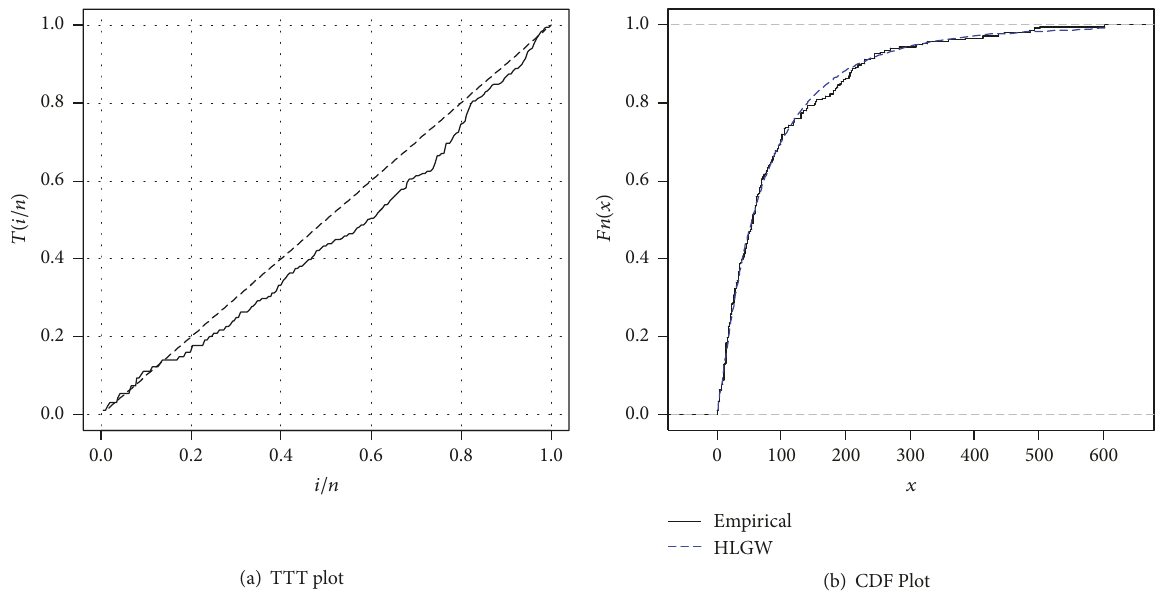
Figure 3: TTT plot and CDF plot for the air conditioning systems failure data.